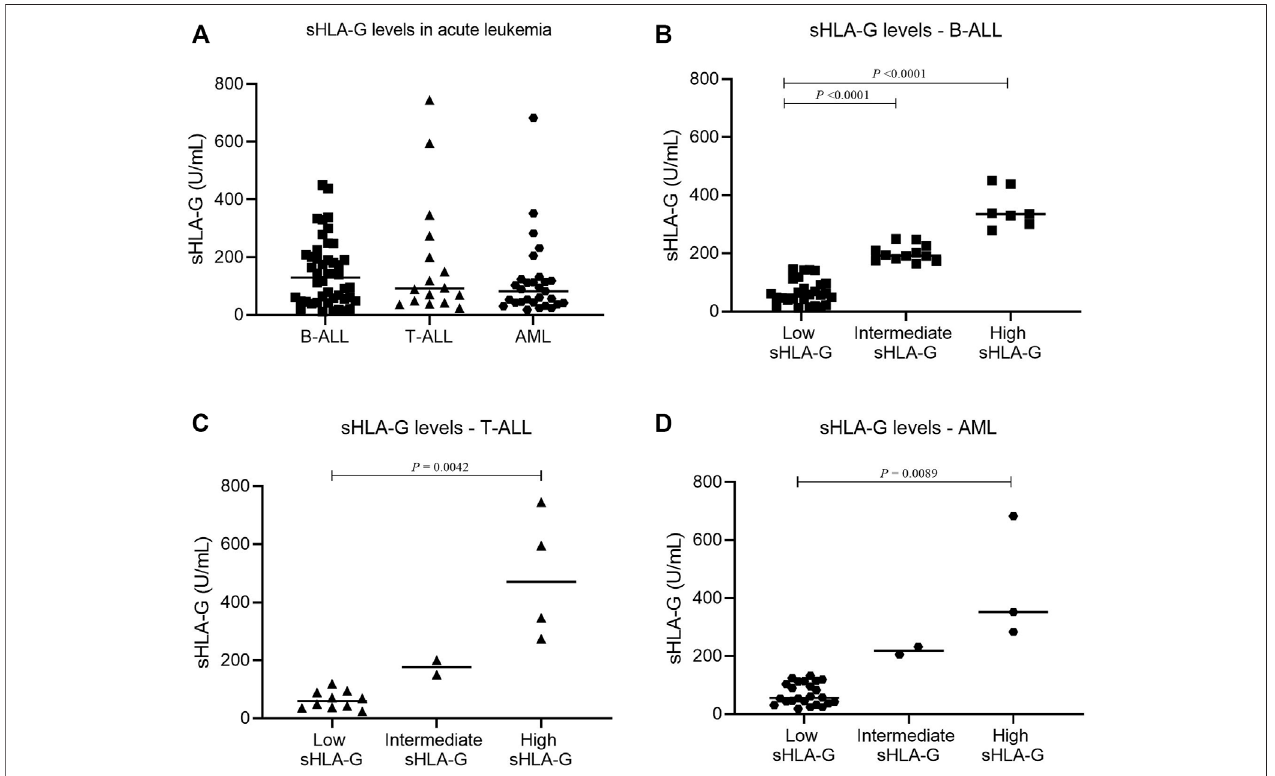
FIGURE 1 | Comparison of sHLA-G levels in the bone marrow stroma of pediatric acute leukemia. (A) sHLA-G in B-ALL (square, n = 46), T-ALL (triangle, n = 16), and AML (hexagon, n = 29); (B) sHLA-G levels in B-ALL (square: low, n = 27; intermediate, n = 12; high, n = 7); (C) sHLA-G levels in T-ALL (triangle: low, n = 10; intermediate, n = 2; high, n = 4); and (D) sHLA-G levels in AML (hexagon: low, n = 24; intermediate, n = 2; high, n = 3). For comparison of the three groups, the Kruskal – Wallis test was used followed by Dunn ’ s multiple comparison for two groups.